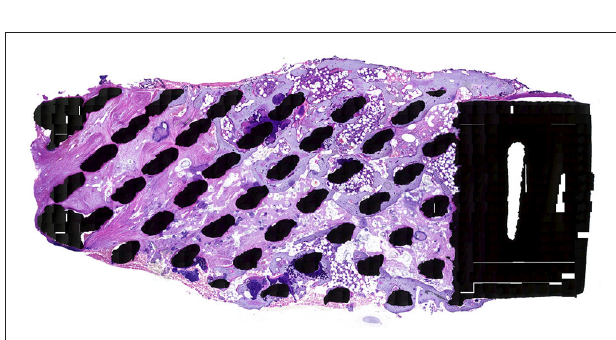
FIGURE 4 | HE stained specimen, 20x magnification: This overview shows direct mature bone apposition onto the titanium struts (black spots), also present in the middle of the cage, indicating that the mechanical stimulation is transferred through the total